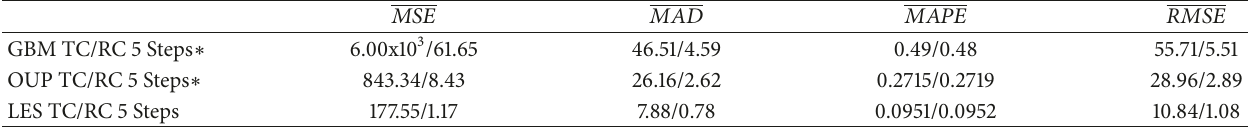
Figure 4: One-step-ahead forecasts (2013), two-step-ahead forecasts (2013-2014) and five-step-ahead forecasts (2013-2017) for TC and RC using the Linear Exponential Smoothing model (LES). Table 17: TC/RC Best error measures for 2013–2017 forecasts after 1000 MC